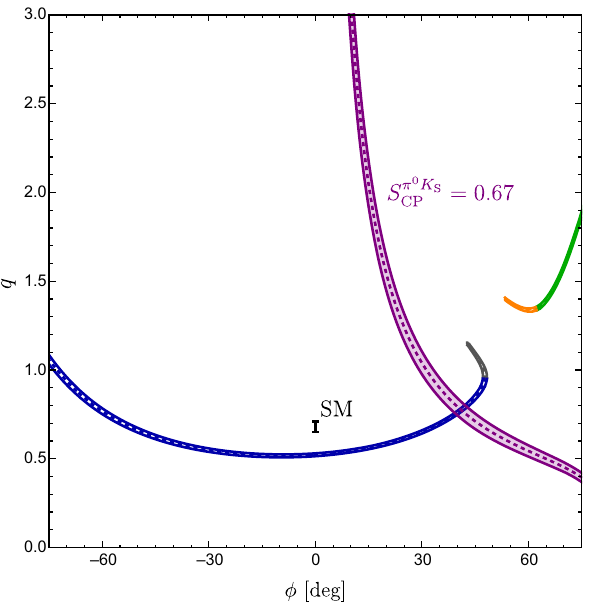
Fig. 15 Scenario1takingonlytheexpectedfuturetheoryuncertainties into account